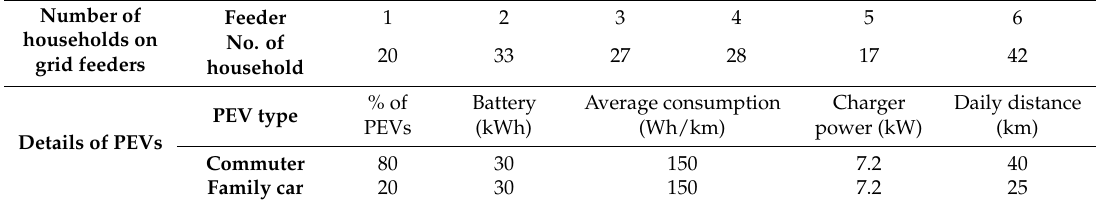
Table 1. Details of feeders and PEVs.